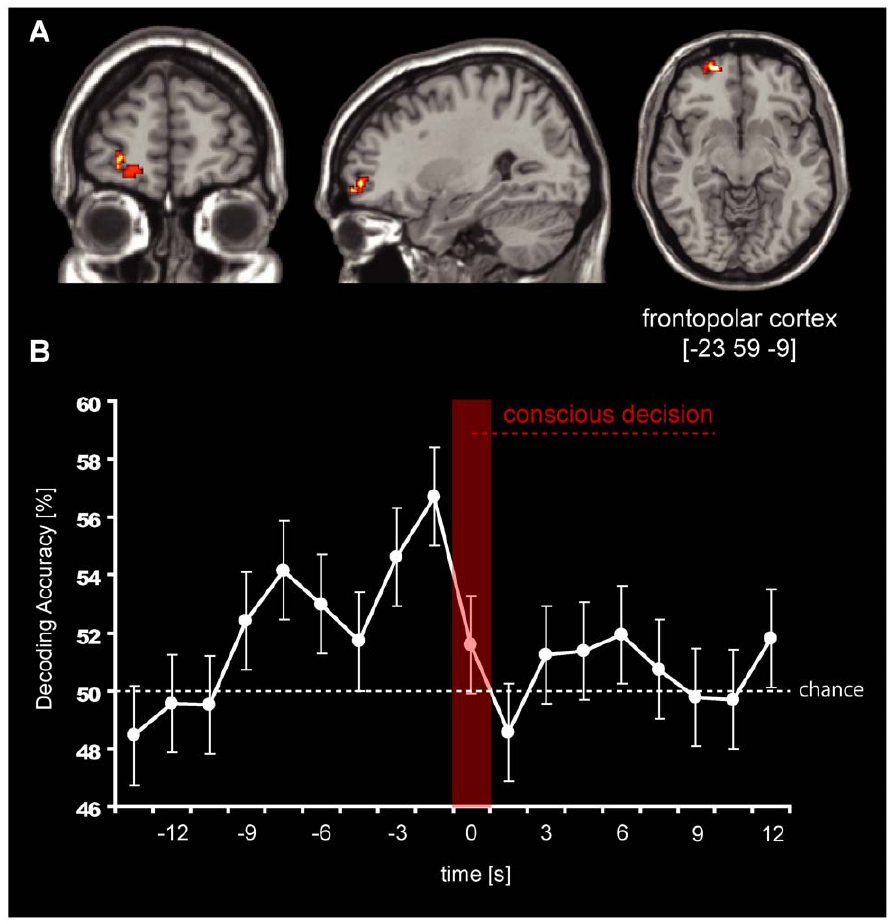
Figure 3. Decoding of upcoming motor decisions from frontopolar cortex. A) The figure displays a region in left frontopolar cortex [ 2 23 59 2 9] from which decoding was possible significantly above chance (50%) using a threshold of p , .05 (FDR corrected; voxel-threshold 5 voxels). FPC only showed significant decoding accuracies in the time-bins preceding the decision. B) The graph displays the average time-course of decoding accuracies, taken from the central voxel of the searchlight cluster that showed the highest decoding accuracy. Error bars represent standard errors. The time-bin of the conscious intention is indicated by the red bar and is labelled as time 0. Time-points preceding the conscious awareness of the intention are labelled as negative numbers (units=seconds, relative to decision); time-points following the decision are therefore positive. One time- bin corresponds to 1.5 s. Coordinates displayed are MNI coordinates.